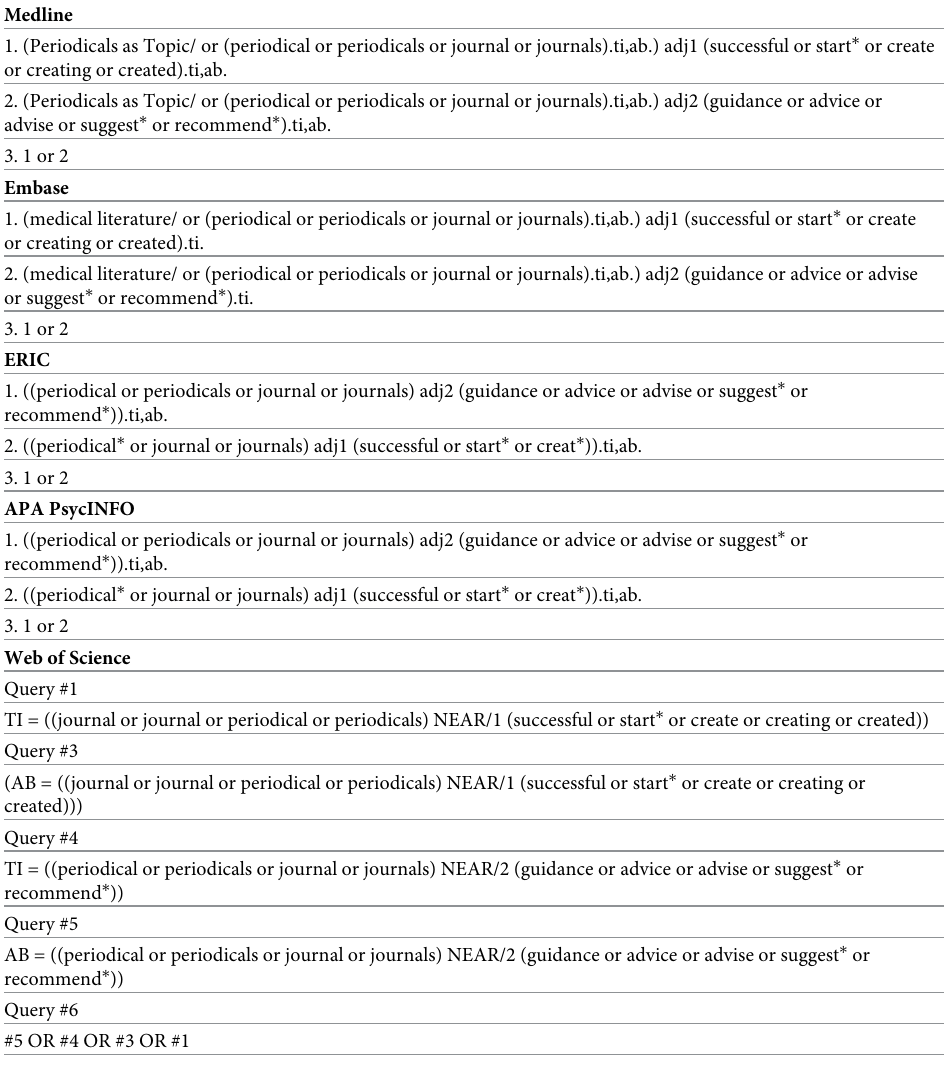
Table 1. Bibliographic database search strategies for articles providing guidance for the creation of new scholarly journals, executed January 14,